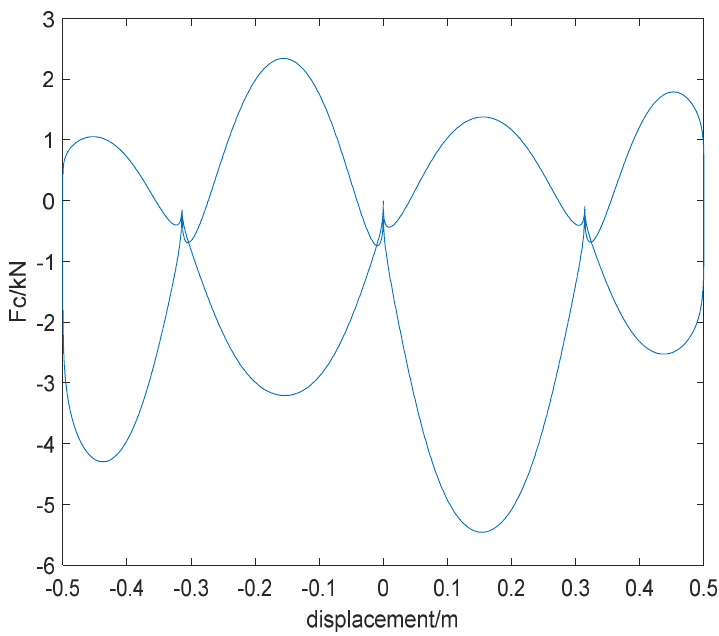
Figure 7.  = 15 and  = 10 damping mechanical model. Figure 7. C = 15 and β = 10 damping mechanical model.